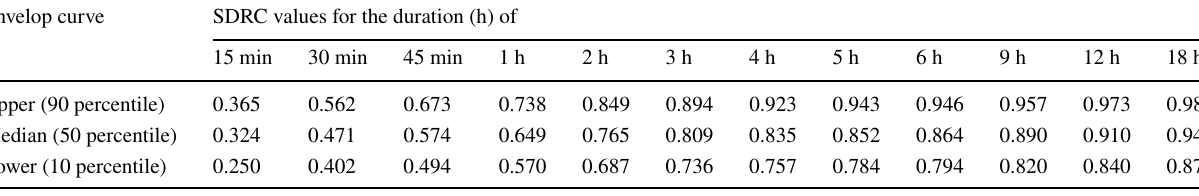
Fig. 3 Variation of short-dura- tion rainfall coefficient (SDRC) to the daily rainfall